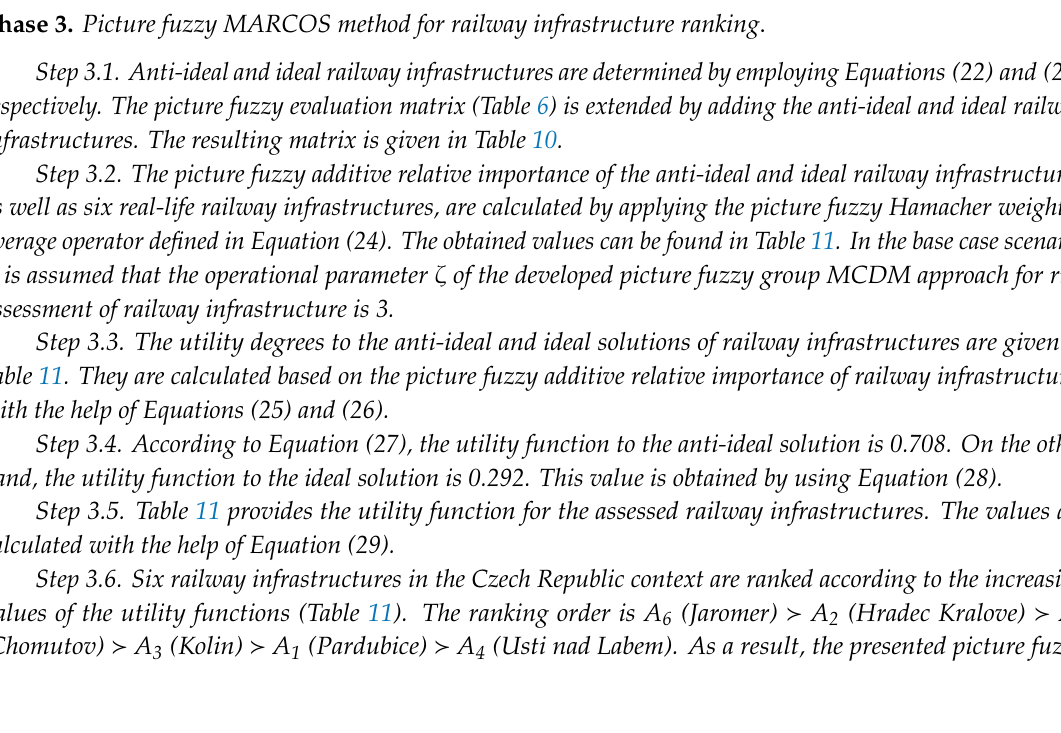
with the help of Equations (25) and